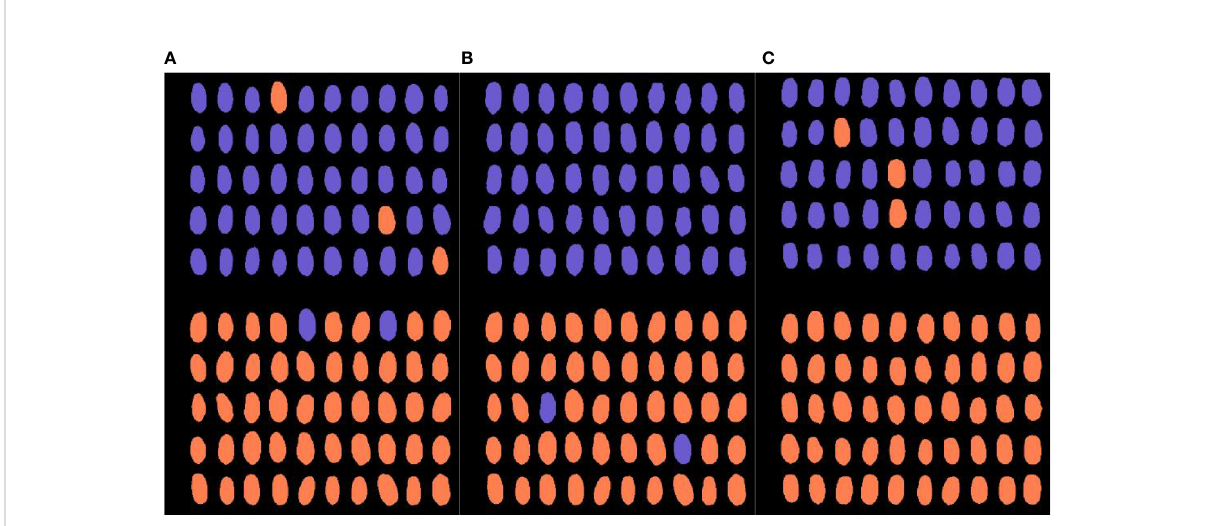
FIGURE 7 Visualization of hybrid seed versus female parent seed classi fi cation results: (A) Jingmai 9, (B) Jingmai 11, and (C) Jingmai